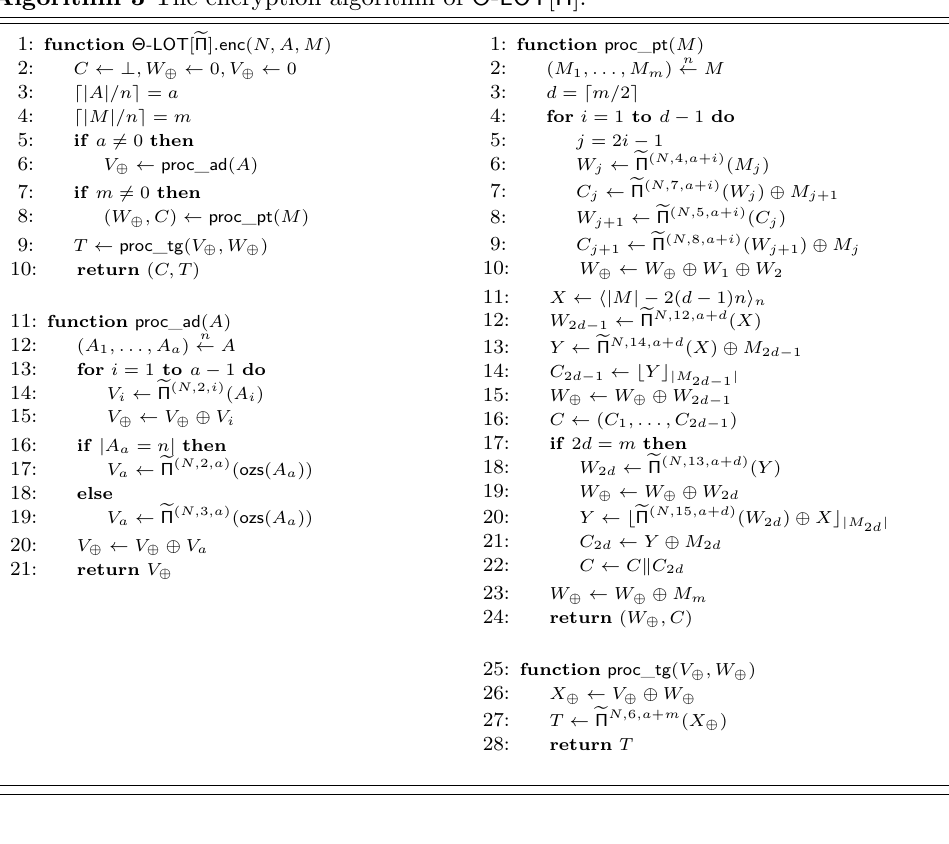
Algorithm 3 The encryption algorithm of Θ-LOT [ e Π ].